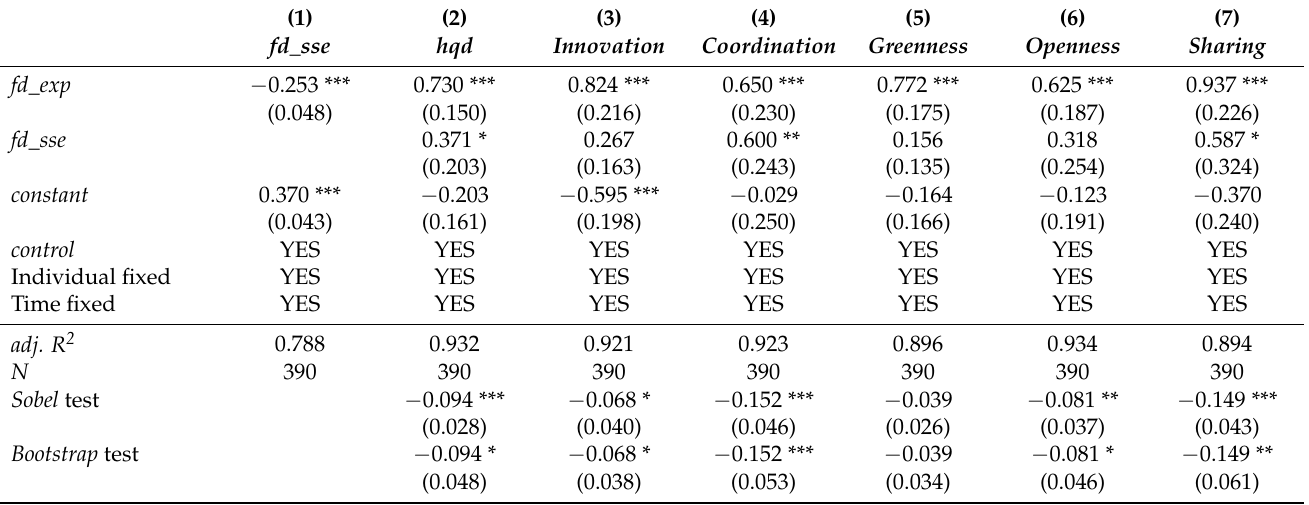
Table 9. Mediating effects of social security employment expenditure preferences based on segmenta- tion